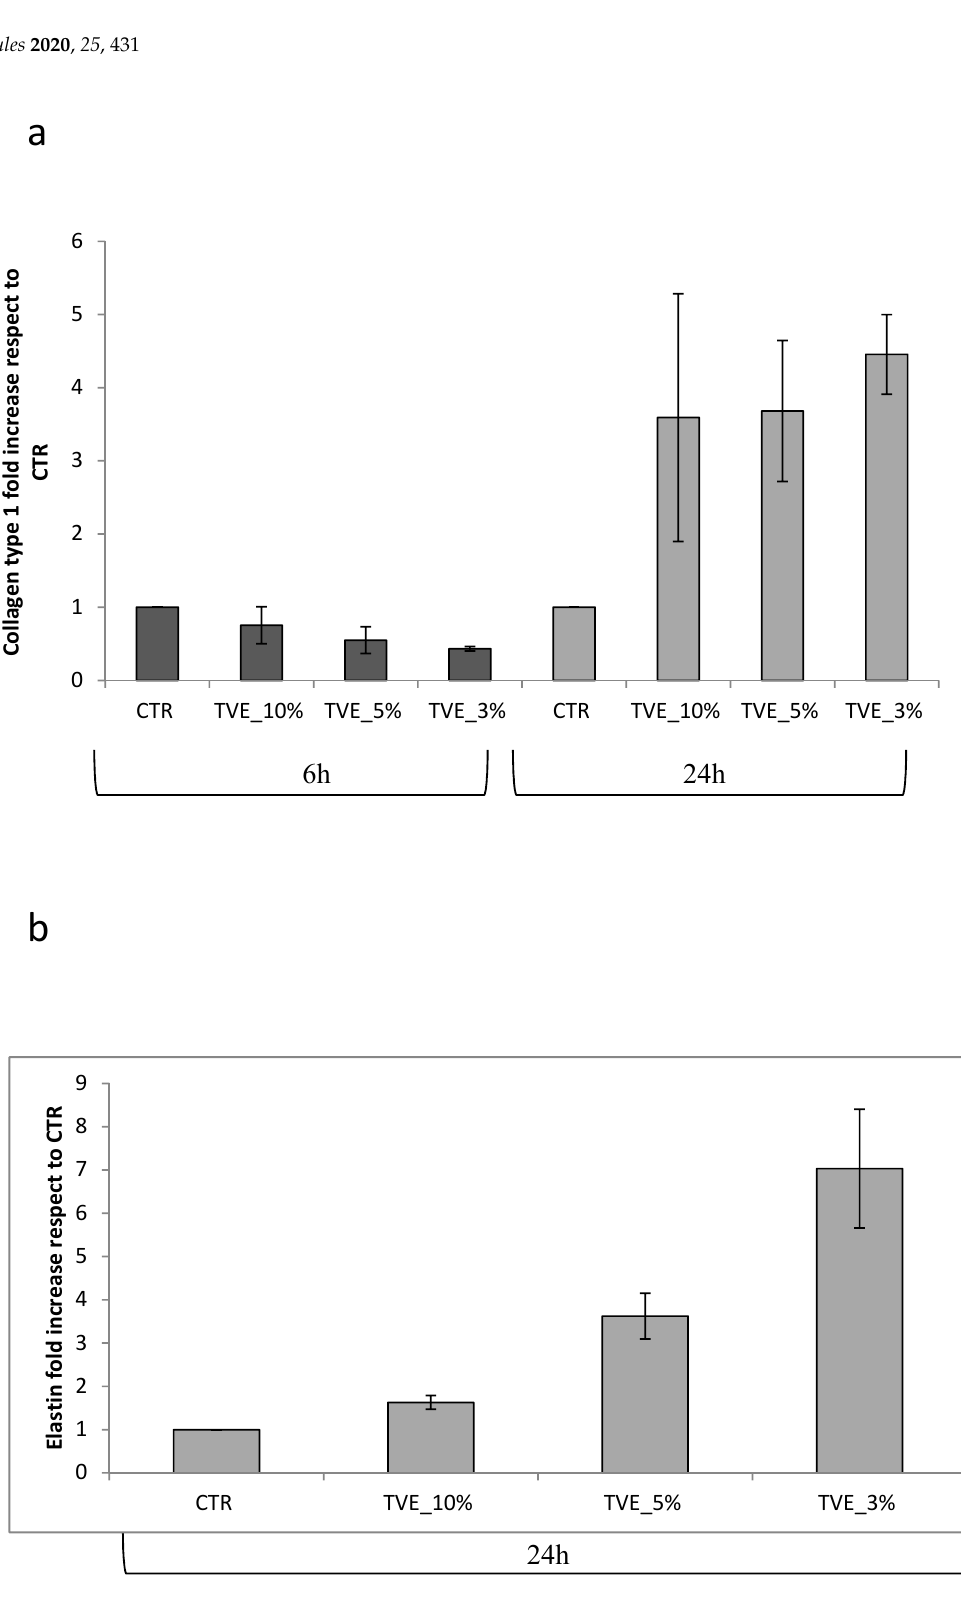
Figure 4. Real-time PCR analysis. The total RNA was extracted and qRT-PCR was performed to determine the gene expression of collagen type I at 6 and 24 h ( a ), as well as elastin expression at 24 h ( b ). Data are presented as mean ± SD.